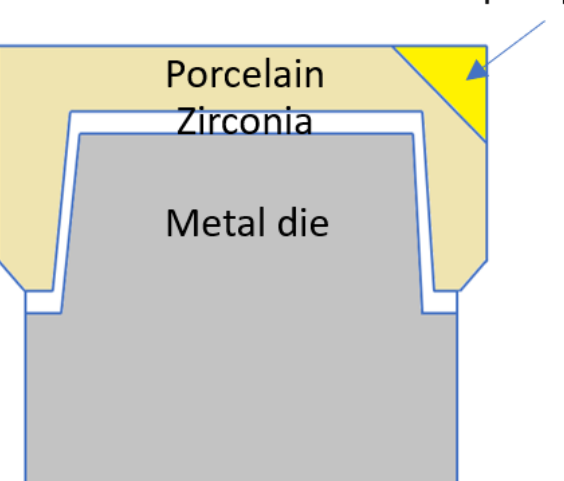
Figure 1. Cross sectional view of specimens used with labeled composition. Cutting plane containing the plane of symmetry of the repaired part and the cylinder axis.